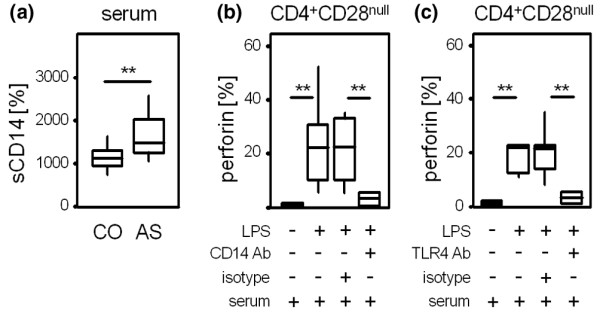
CD14 and TLR4-mediated effects. (a) ELISA assays were performed to analyse levels of soluble CD14 (sCD14) in sera from patients with ankylosing spondylitis (AS) (n = 50) and healthy controls (CO) (n = 23). The Mann-Whitney test was used to determine the statistical differences between the group of patients and the control group. **P < 0.01. A blocking antibody (Ab) directed against (b) CD14 and (c) TLR4 or an isotype control were added to peripheral blood mononuclear cells from patients with AS maintained in 5% autologous serum. After 1 hour, lipopolysaccharide (LPS) stimulation at a concentration of 10 μg/ml for 16 hours was started. Box blots show percentages of perforin-producing CD4+CD28null T cells from seven independent experiments. Differences were tested for significance using the Wilcoxon test. **P < 0.01.